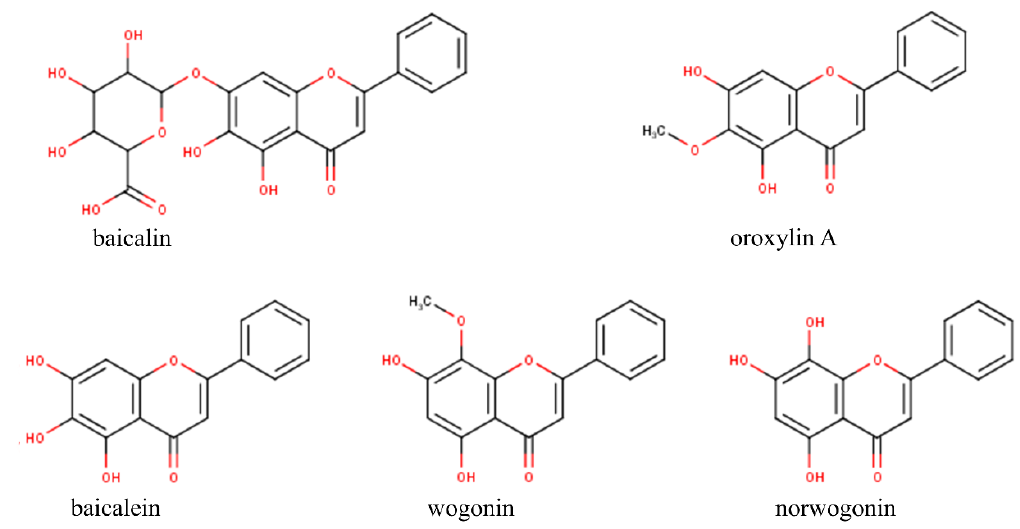
Figure 1. Chemical structure of the flavonoids baicalin, oroxylinA, baicalein, wogonin, and norwogonin from Scutellaria baicalensis.